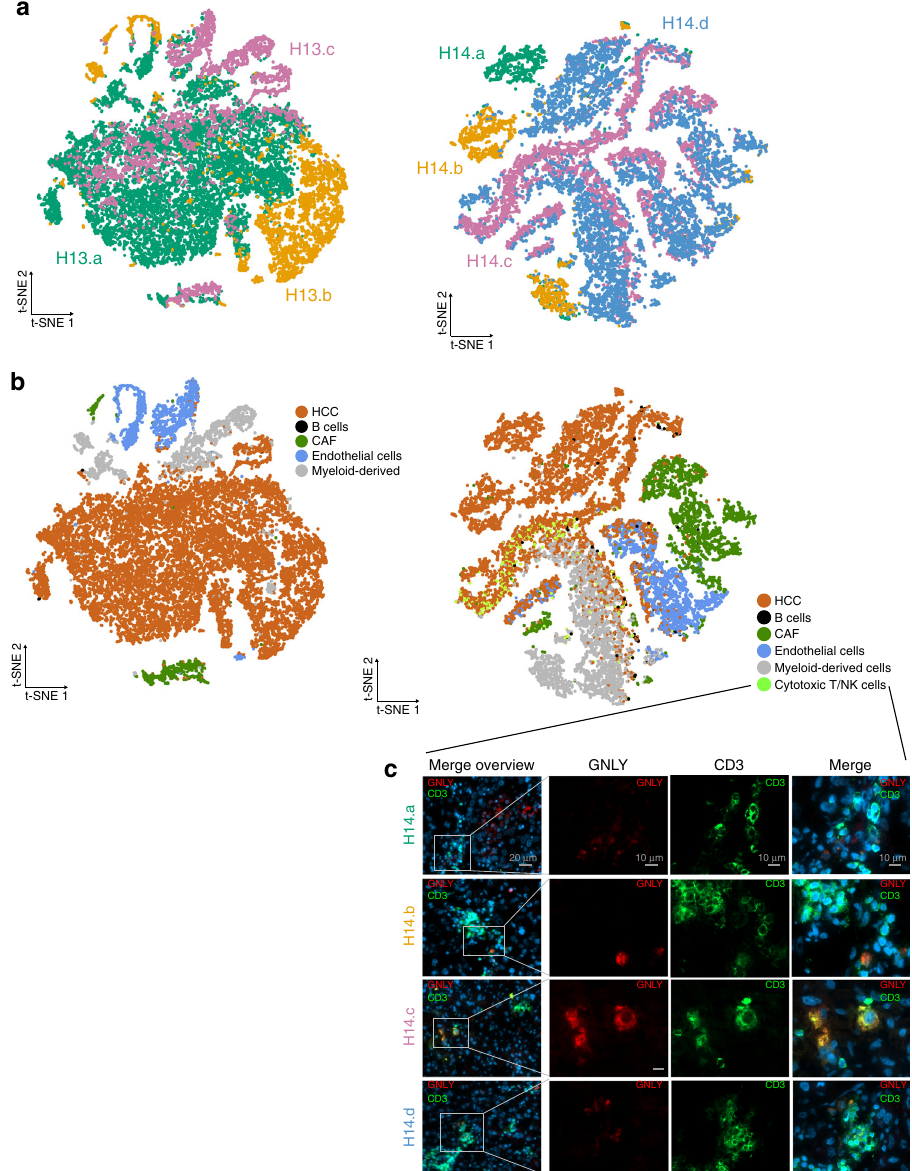
Fig. 6 HCC ecosystem and regional transcriptomic heterogeneity on single-cell RNA-seq. a t-SNE plots of single-cell clusters colored by tumor region (H13.a: Green; H13.b: Yellow; H13.c: Pink) and b af fi liation to cell lineage by gene expression. c Immuno fl uorescence staining for GNLY (red) and CD3 (green) in P14. Scale bar is 20 μ m long in merge overview panels and 10 μ m for all other panels. N = 3 independent experiments. Source data are provided as a Source Data fi